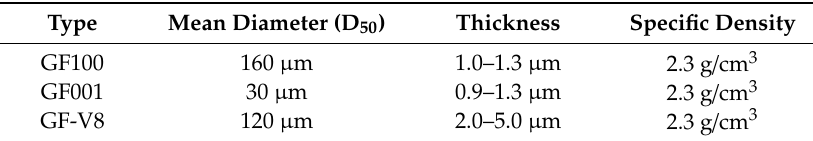
Figure 2. Scanning electron microscopy (SEM) image of commercial Micro Glass Flakes (MGF). Table 1. Properties of Micro Glass Flakes used in this study.